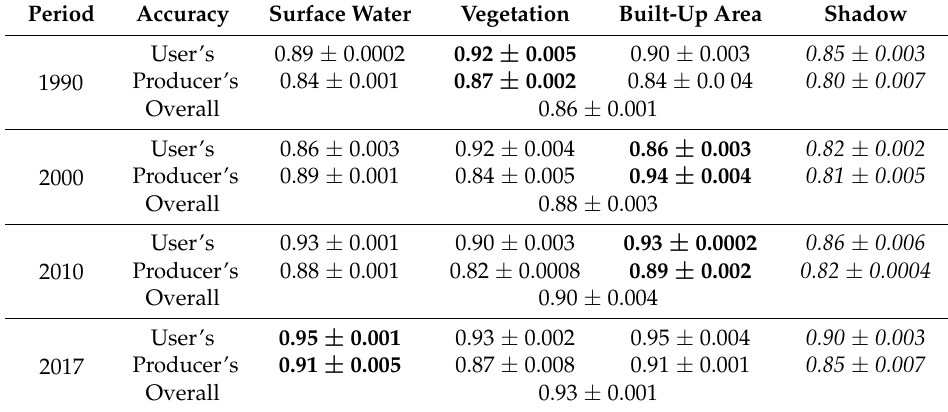
Table 3. Results of error matrixes of land cover in 1990, 2000, 2010, and 2017. The value after the symbol “±” represents the margin of error with confidence level 95%.